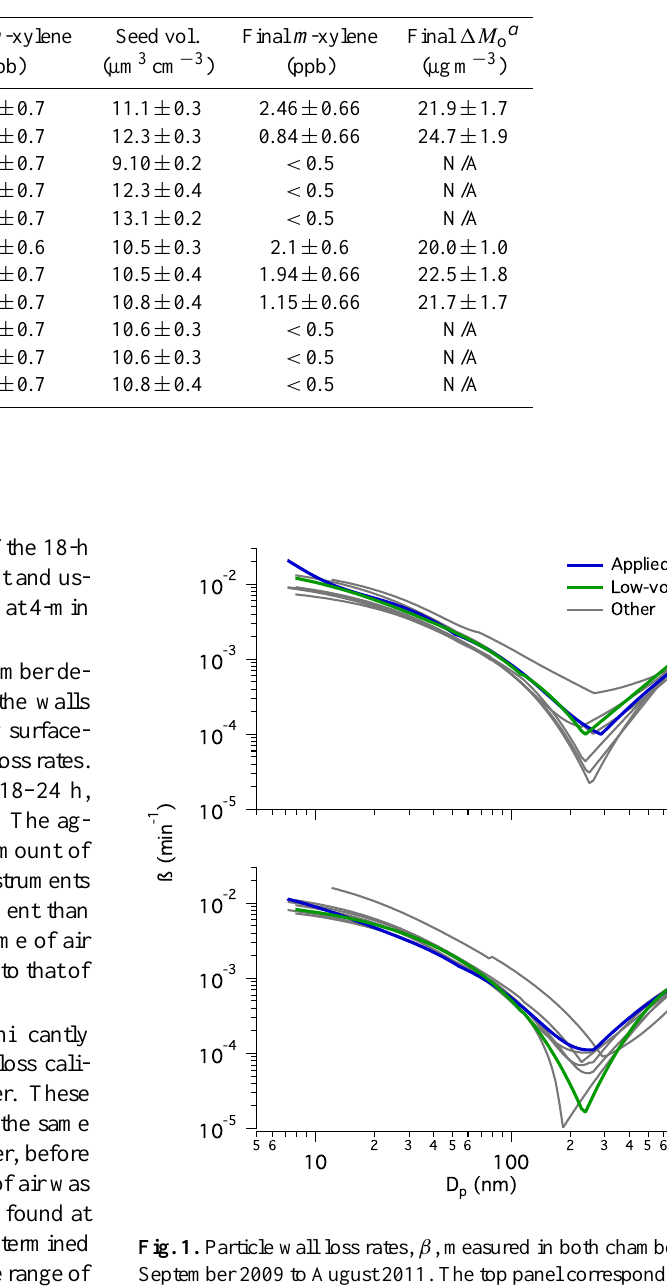
Table 2. Experimental conditions and results.